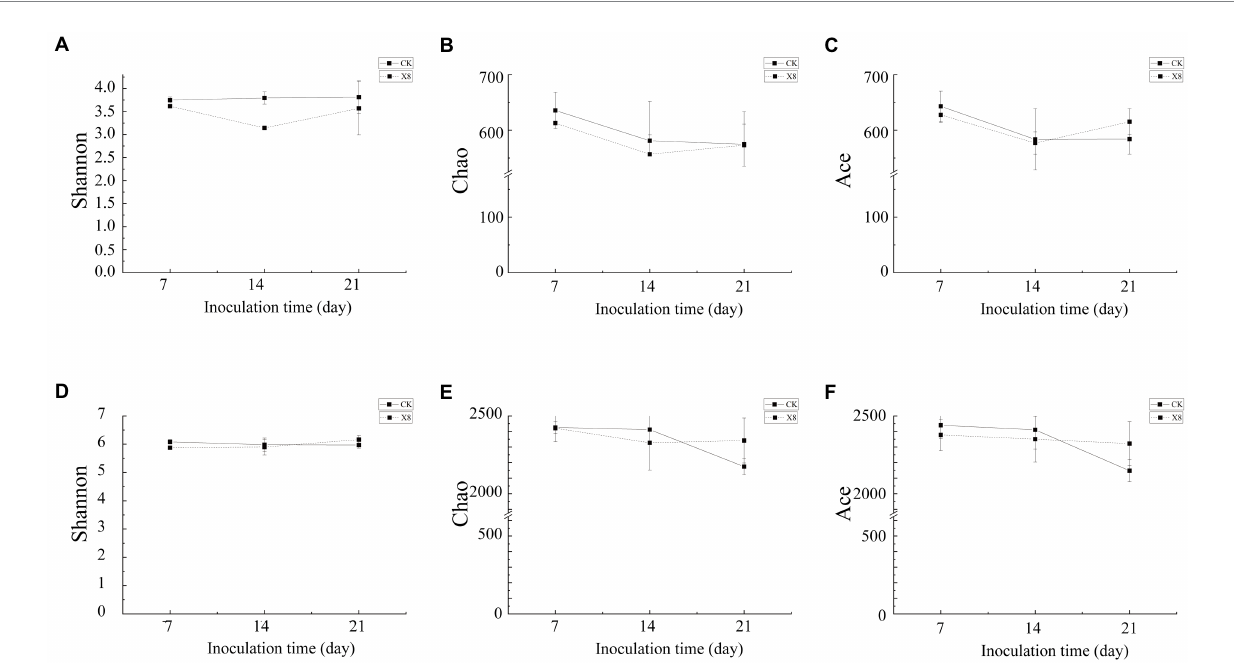
FIGURE 6 Alpha diversity of fungal and bacterial communities. (A–C) Fungal community. (D–F) Bacterial community. X8 refers to C. cateniannulata X8, CK refers to the control. All the data are presented as mean ± SE ( n = 3). SE–standard error of the mean.